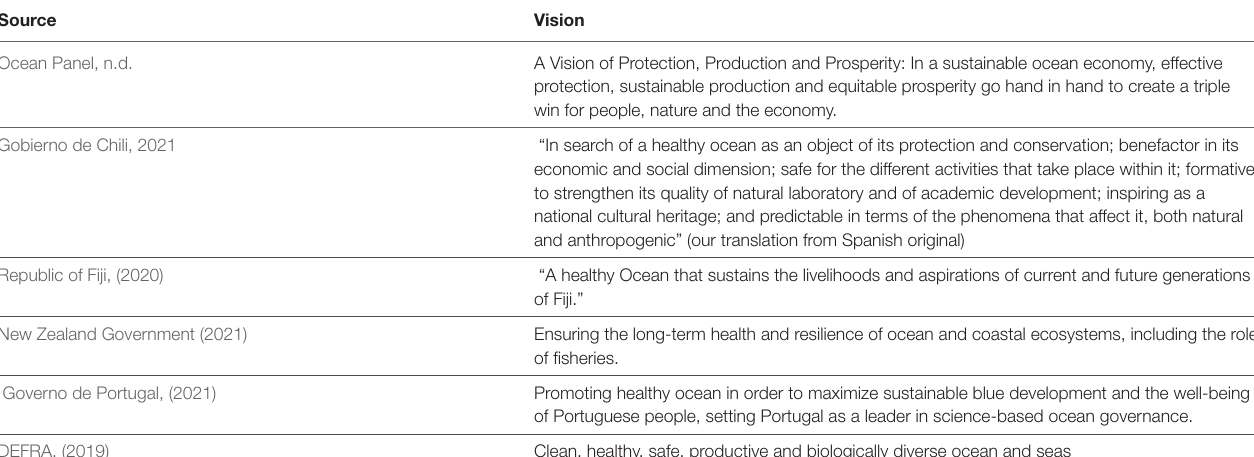
TABLE 1 | Examples of existing Ocean Visions. Source Vision Ocean Panel,